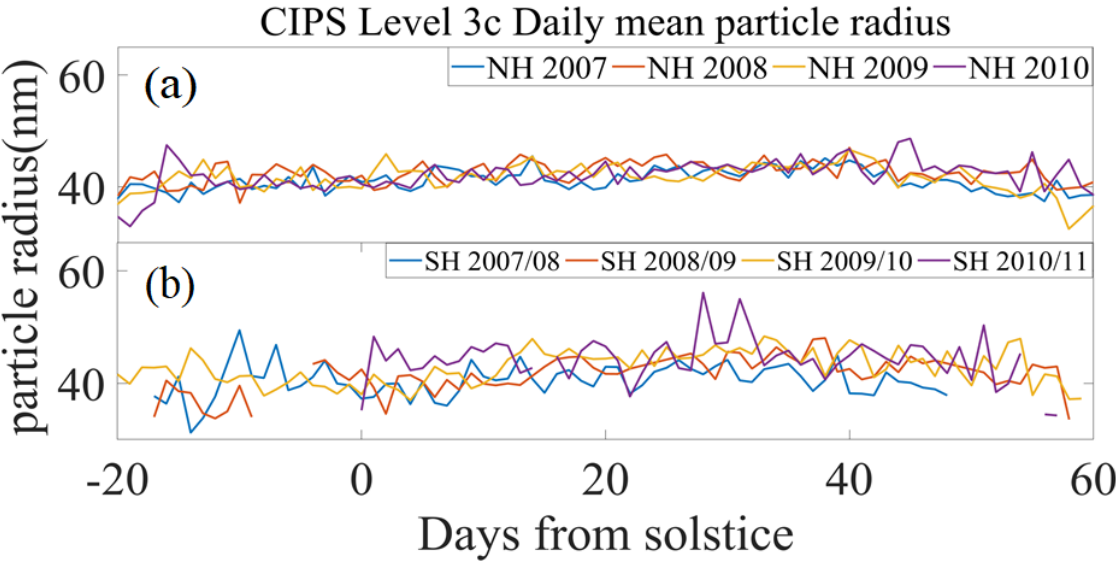
Figure 6. The particle radius distributions for the PMC seasons from 2007 to 2010 in NH ( a ) and 2007/2008 to 2010/2011 in SH ( b ).